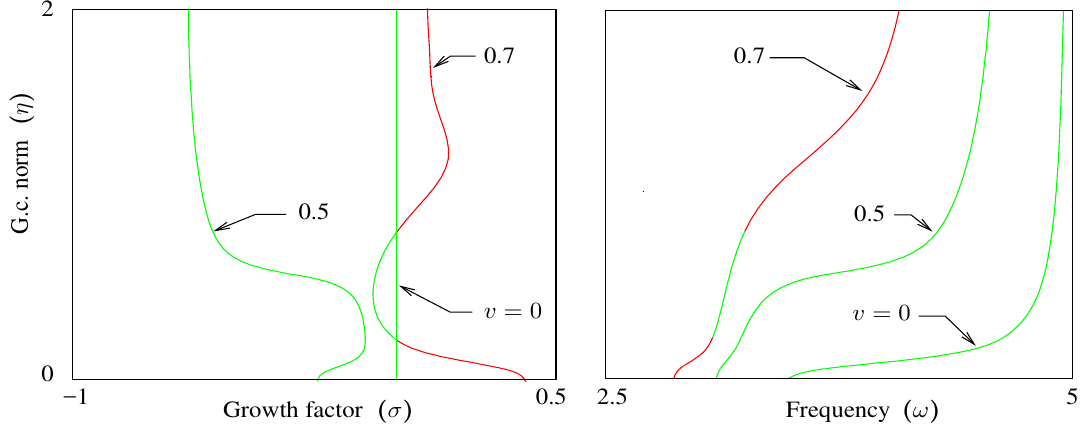
Figure 7. Processes 2, 5 and 6: σ - ω - η at 3 normalized velocities (Green means stable, red means